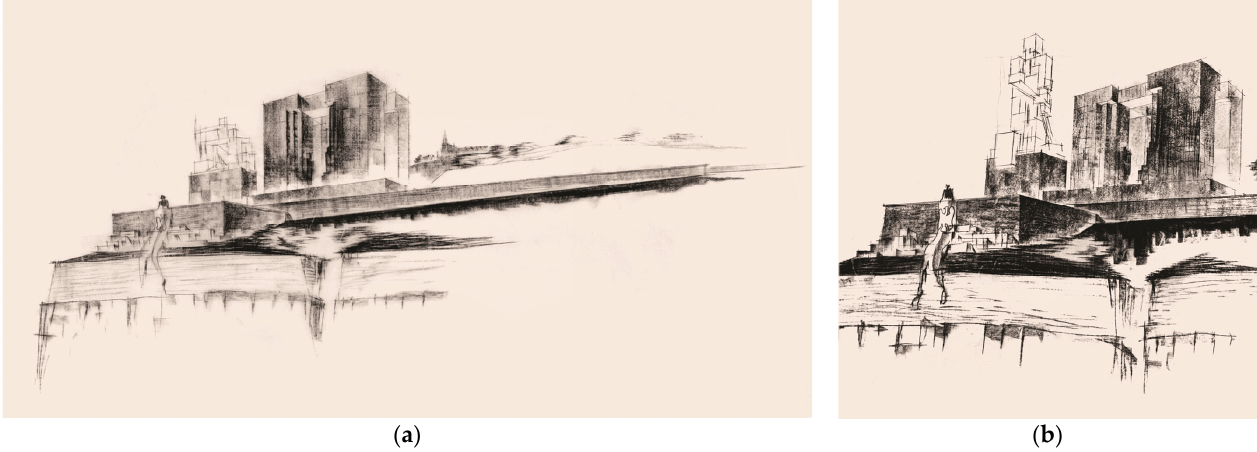
Figure 5. Saint Anne Mountain, the Monument of the Insurgents’ Deed; Xawery Dunikowski’s design (in cooperation with Andrzej Frydecki), view of the dolmen with ( a ) the statue of an archer or ( b ) insurgent, drawing by Andrzej Frydecki, 1948 (Museum of Architecture in Wroclaw).